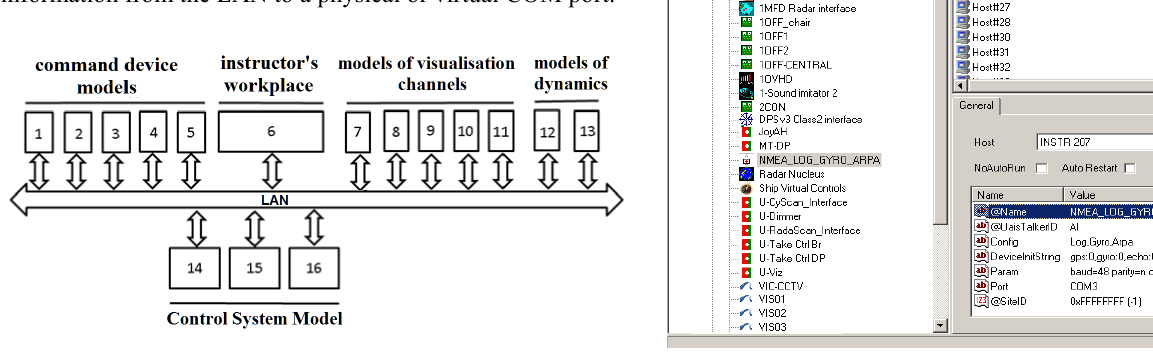
Fig. 3. Structural diagram of the Imitation Modelling Stand. Fig. 4. Screenshot of standard Configuration Editor simulator program.